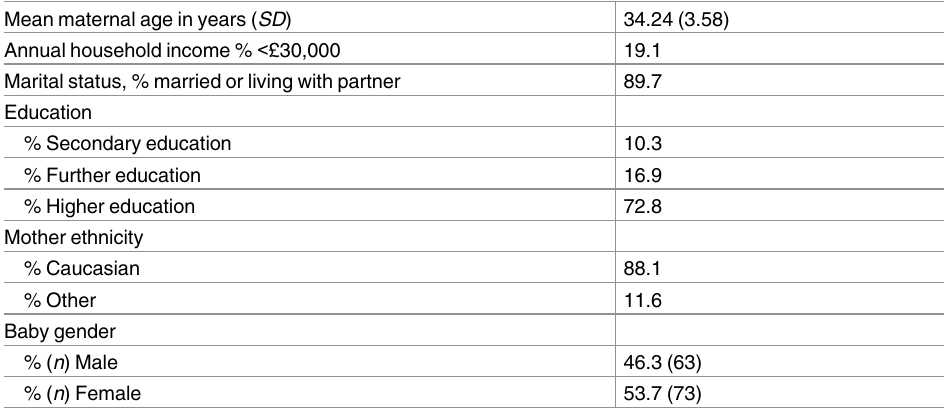
Table 10. Demographic features of participants in Study